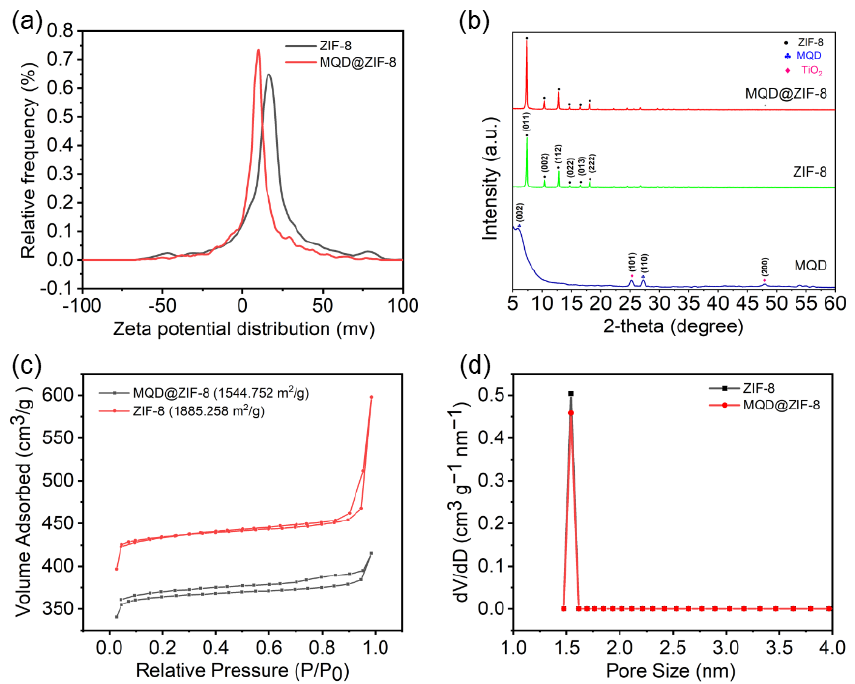
Figure 2. ( a ) Zeta potential spectra of ZIF-8 and MQD@ZIF-8 samples; ( b ) XRD patterns of ZIF-8, MQD, and MQD@ZIF-8. ( c , d ) N 2 adsorption–desorption isotherms and pore size distribution curves of ZIF-8 and MQD@ZIF-8 samples.